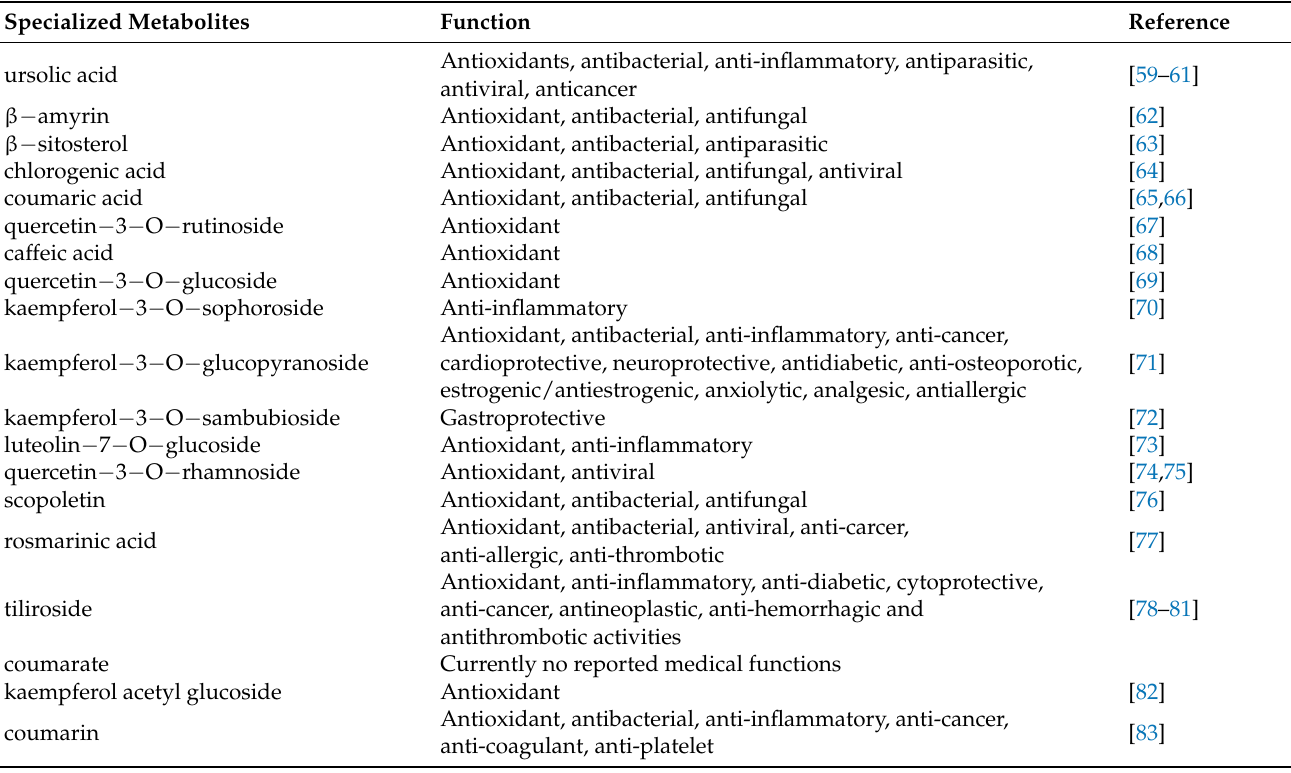
Table 2. Medical functions reported for each majority compound purified from three white oak species ( Q. rugosa , Q. obtusata, and Q. glabrescens ) from the Trans-Mexican Volcanic